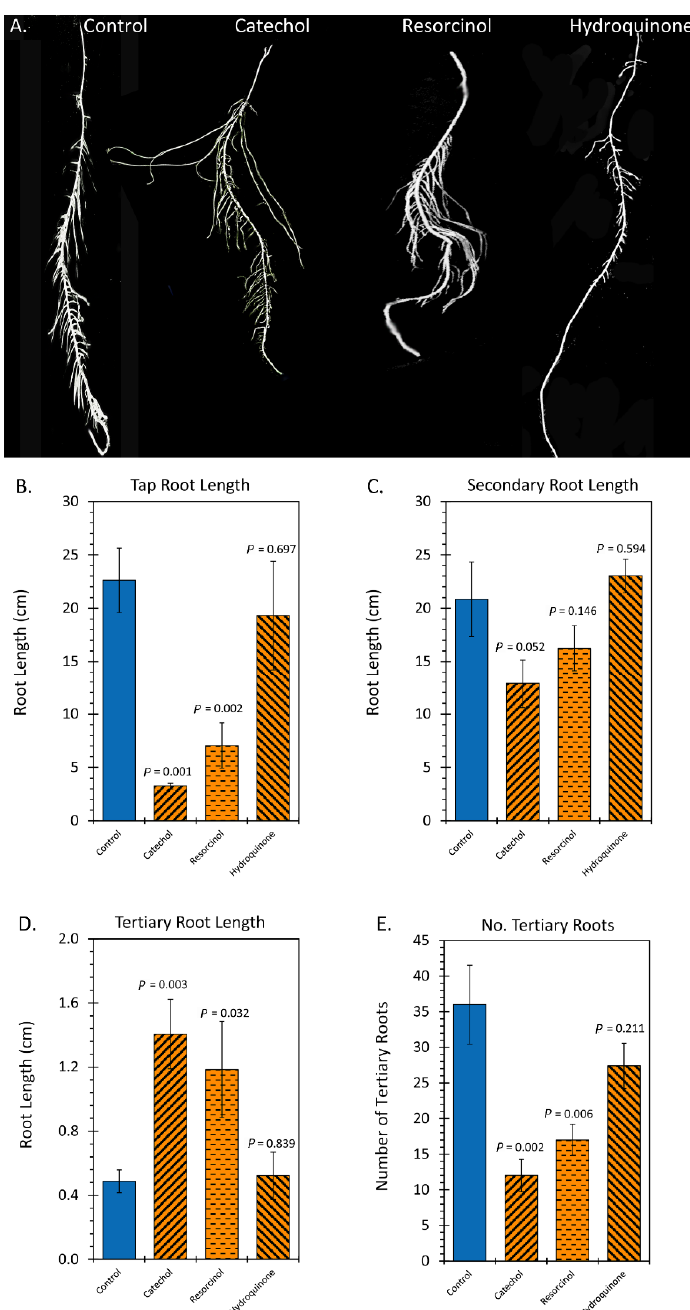
Figure 6. Effect of chemical treatments on sunflower root architecture. Panel ( A ): Digital photographs of floated isolated roots from rhizobox studies from control, catechol, resorcinol, and hydroquinone treated plants. Panel ( B ): taproot length in centimeters measured from full rhizobox digital images taken during studies (see Figure 3C–F). Panel ( C ): secondary root length in centimeters measured digitally from floated root images. Panel ( D ): tertiary root length in centimeters measured digitally from floated root images. Panel ( E ): number of tertiary roots tallied per isolated secondary root. All graphical data bars reflect average values ± SE (N = 4). p ‐ values < 0.05 were considered statistically significant.